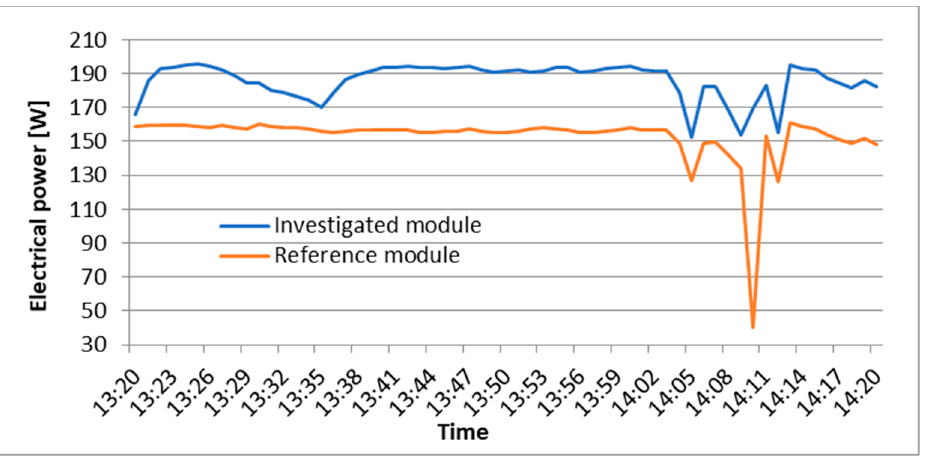
Figure 11. Power of investigated and reference modules during the maximal power test.